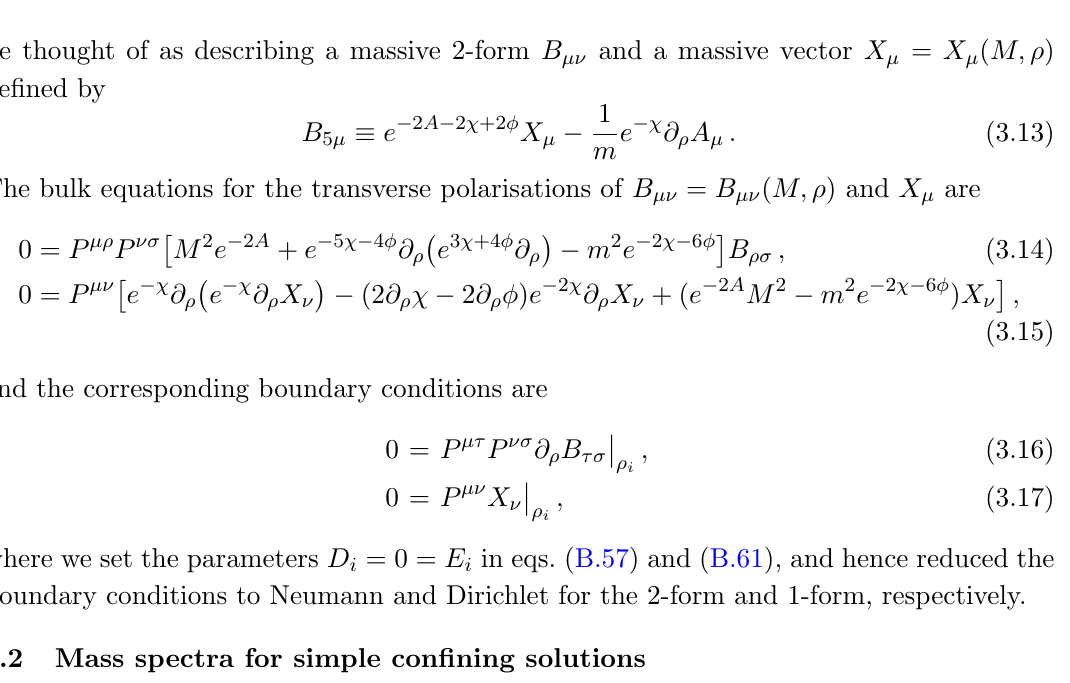
Table 1 . Masses M of the (cid:12)rst few excitations in all 10 towers of states, normalised to the mass of the lightest tensor mass, computed on backgrounds with (cid:30) = (cid:30) UV = 0. The numerical calculations are performed by setting the IR cuto(cid:11) to (cid:26) 1 = 0 : 001, and the UV cuto(cid:11) to (cid:26) 2 = 8. The numerical solutions are obtained by the midpoint determinant method, computed at the intermediate (cid:26)